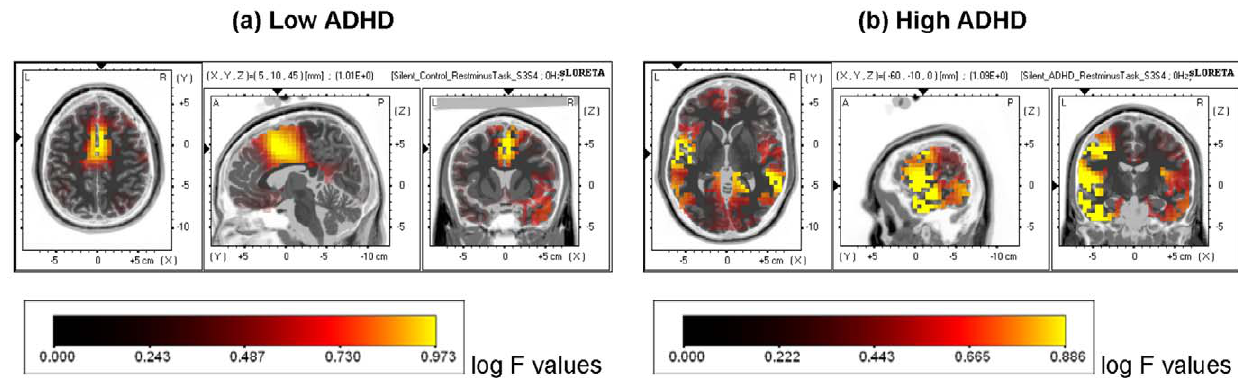
Figure 3. Localisation of attention-induced deactivation of VLF EEG (0.02–0.2 Hz). Localisation of VLF EEG shown for the (a) low ADHD group and (b) high ADHD group. Significant voxels are shown in yellow ( p , .05).